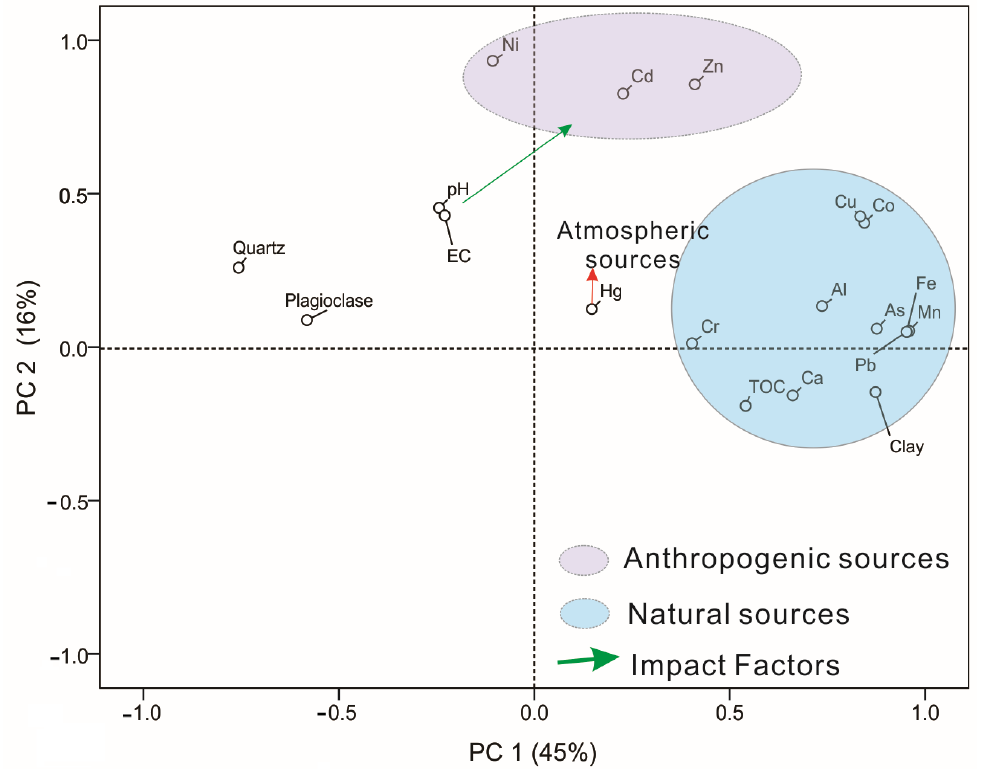
Figure 7. PCA for the nine heavy metals, pH EC, and elements in surface soils from Hetao Plain in Bayannur.